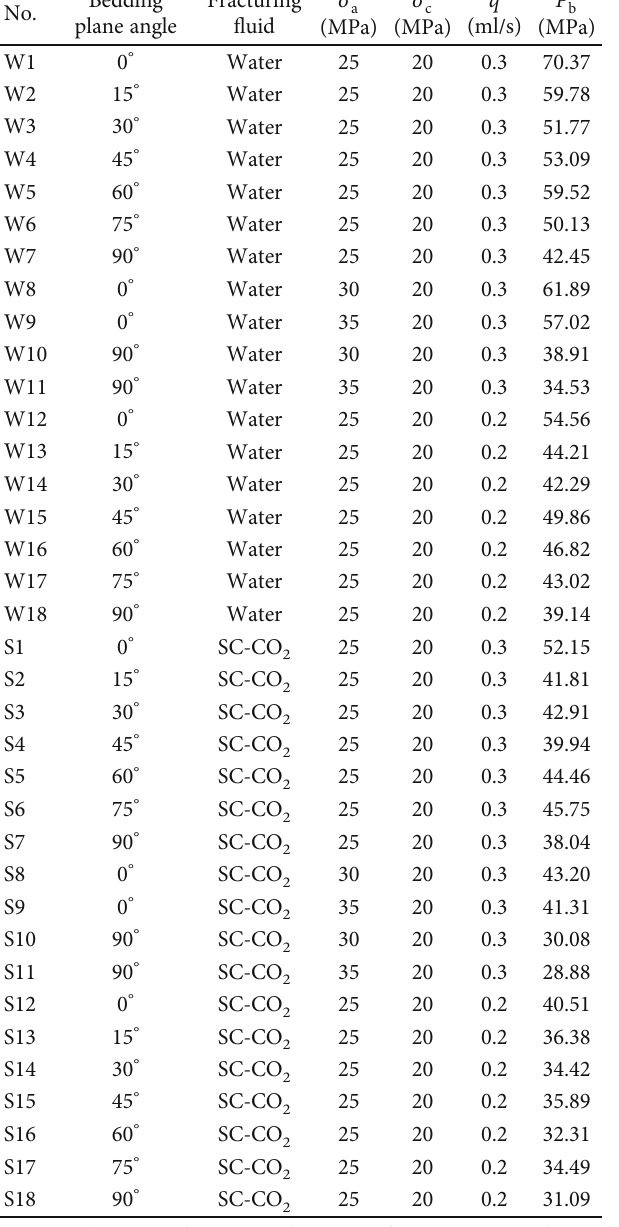
Table 1: Summary of the fracturing experiments results. Bedding No.